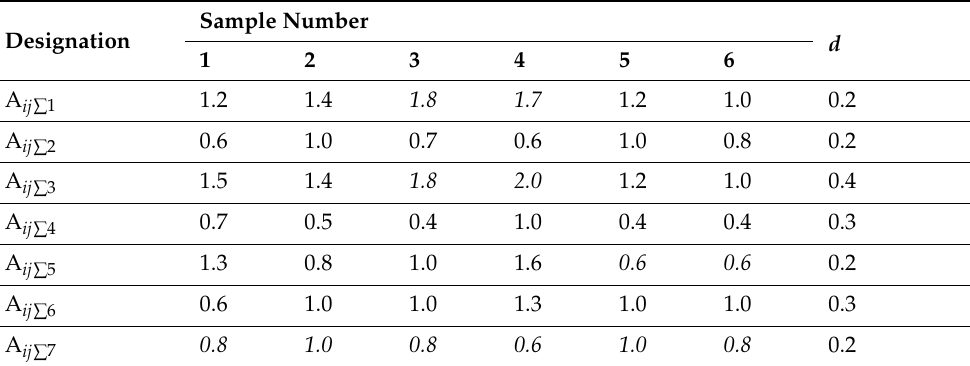
Figure 7. “Visual prints” of sensor responses in an array with polycomposite coatings in the EGP over EBC samples: numbers of sensors with polycomposite coatings in an array and scanning time (10, 60 s) are plotted along the radial axis. The part of “visual print” reflected the presence of dis- ease in calf is selected by blue circles. Table 15. Parameters A ij ∑ for EBC samples, calculated considering the kinetic features of sorption on